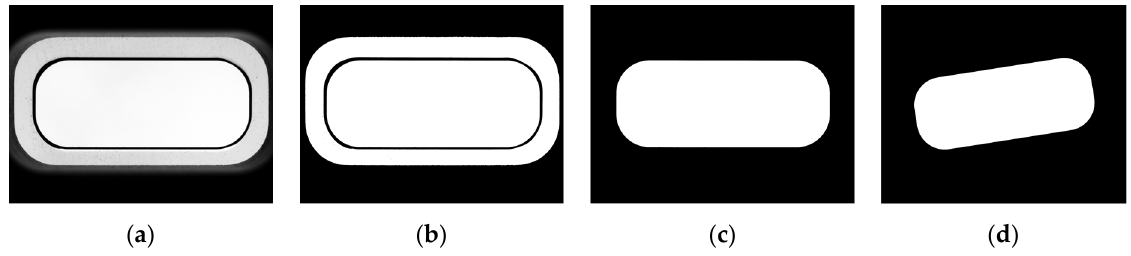
Figure 18. Experimental image sample and preprocessed image for the experiment: ( a ) experimental image sample; ( b ) iterative binarization; ( c ) flood filling; ( d ) rotation.